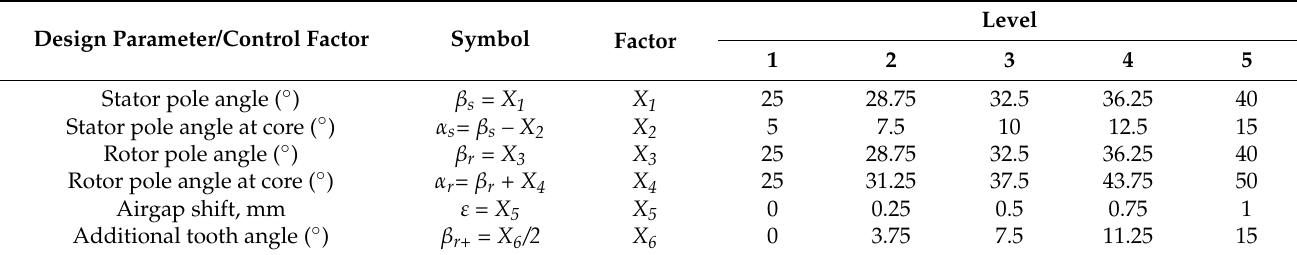
Table 2. Design parameters’ sampling.